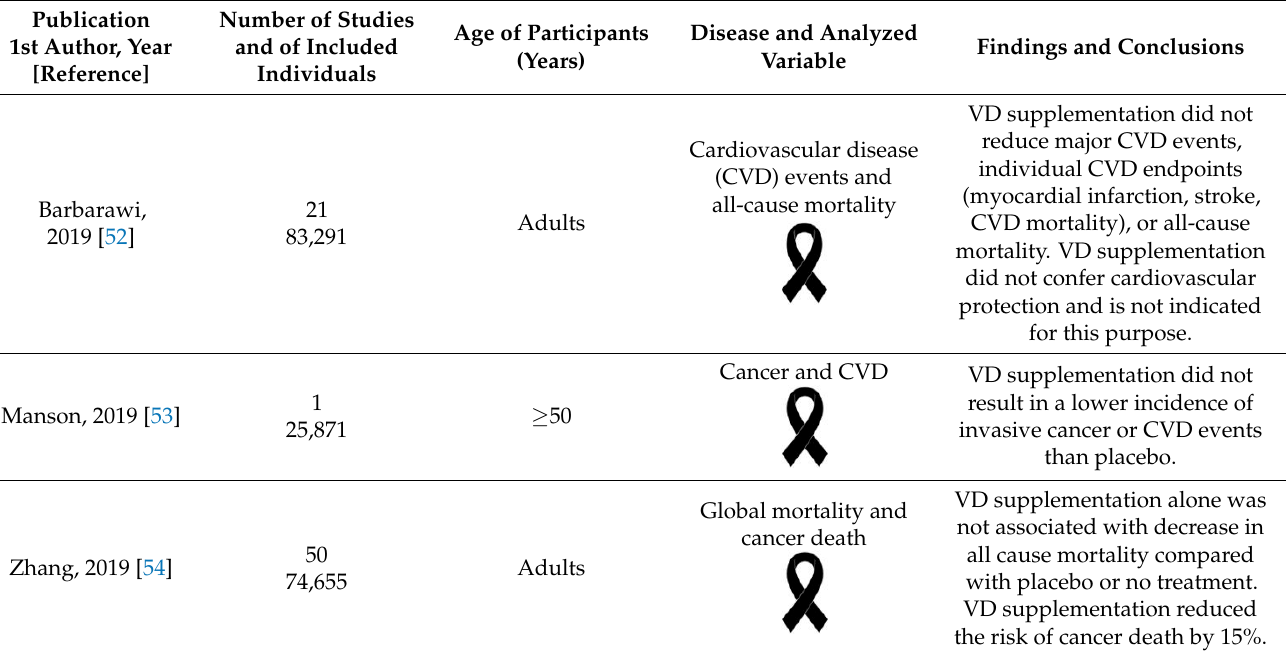
Table 5. Most significant randomized controlled trials (RCT) and systematic reviews published in the last 5 years analyzing the effect of vitamin D (VD) supplementation in patients with systemic diseases